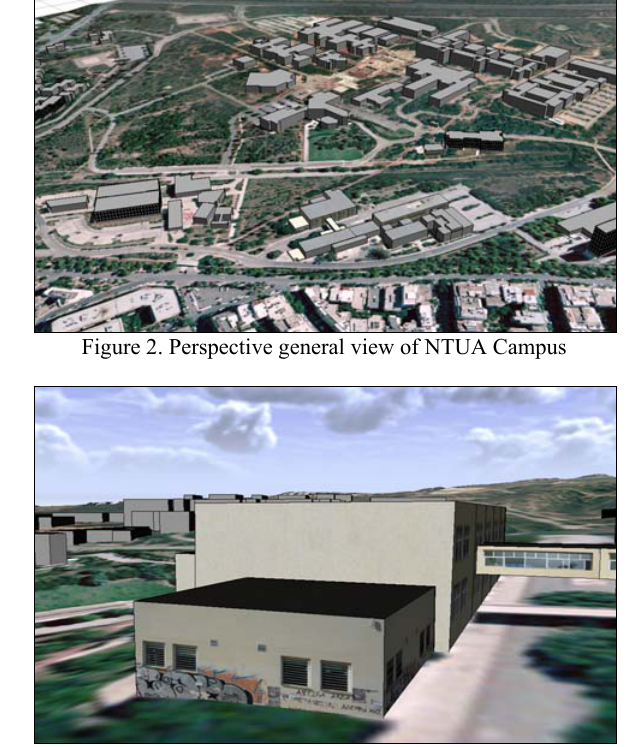
Figure 3. Perspective view of Veis building of